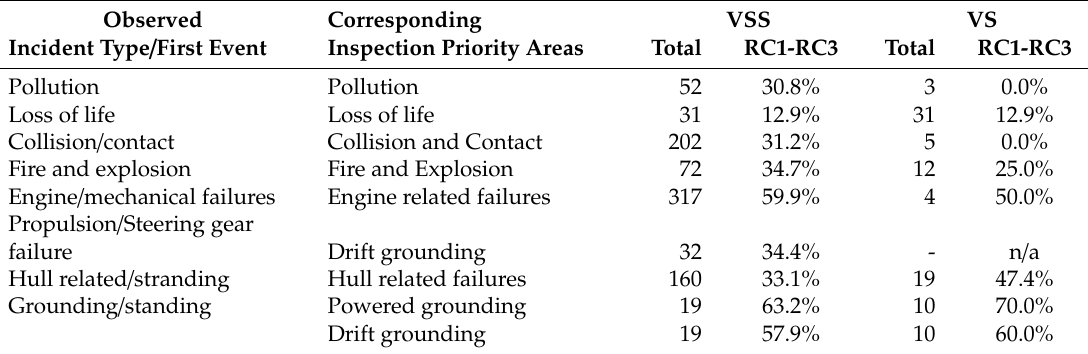
Table 6. Percentage of vessels identified in risk Category 1 to 3 by inspection priority risk areas